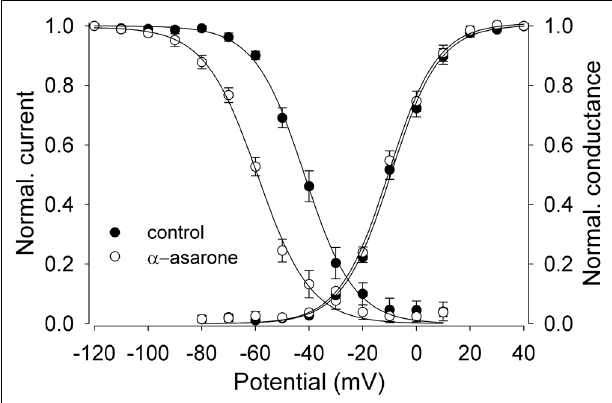
FIGURE 3 | Effects of α -asarone on voltage-dependent availability and activation of Na v 1.2 channels. The shift of inactivation curves of Na v 1.2 channels by 500 μ M asarone ( n = 5).The voltage dependence of steady-state inactivation ( h ∞ ) was examined by applying 500-ms prepulse potentials from –120 to 10 mV in 10-mV increments from a holding potential of –100 mV before stepping to the test potential (0 mV) for 35 ms. The peak current (I) for each cell was normalized with respect to the first value measured at test potential (0 mV). Conductance–voltage relationship: from the peak Na + currents obtained in Figures 2A,B , the Na + conductance values ( G ) in the absence and presence of 500 μ M α -asarone were calculated, normalized to the maximum in control, and plotted as a function of membrane potentials ( V ).The smooth curves through the data are drawn according to the equation: y = 1/1 − exp[( V − V h )/ k ].Where V = membrane potential, V h = the prepulse potential where the current is half-maximal, and k = the slope factor.